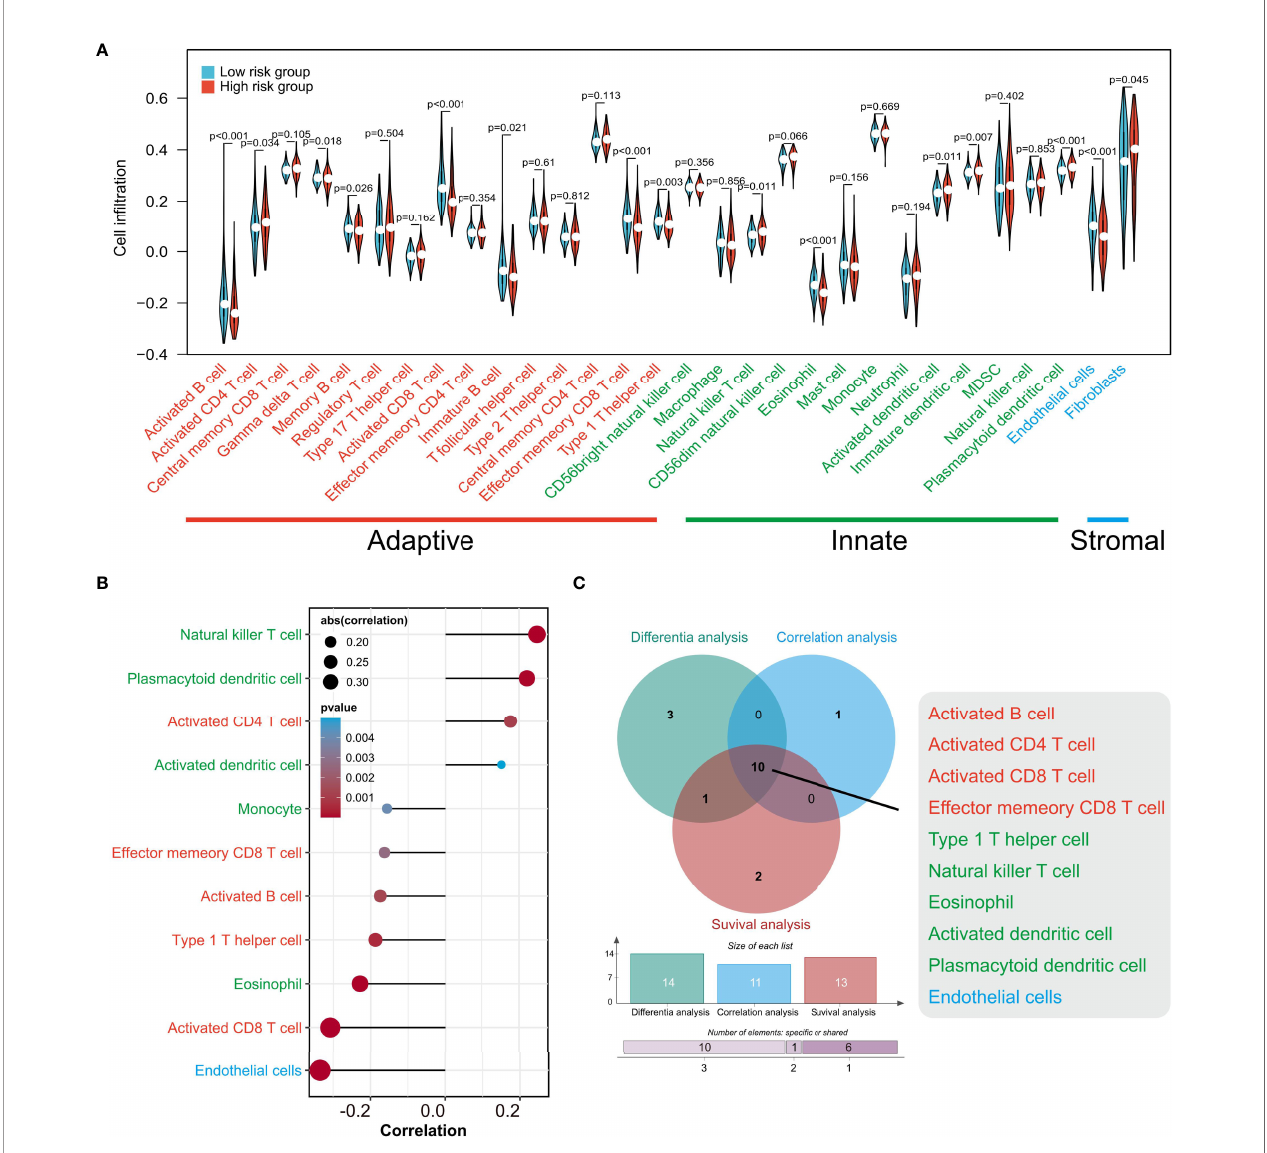
FIGURE 8 | The associations of TIPRGPI and in fi ltration of TME cells estimated by ssGSEA. (A) The differences of TME cell in fi ltration between low- and high-risk groups. (B) Correlations between the risk score and TME cells. (C) Venn diagram revealing 10 types of most relevant TME cells contributing to the risk strati fi cation of HCC patients by TIPRGPI. TME, tumor